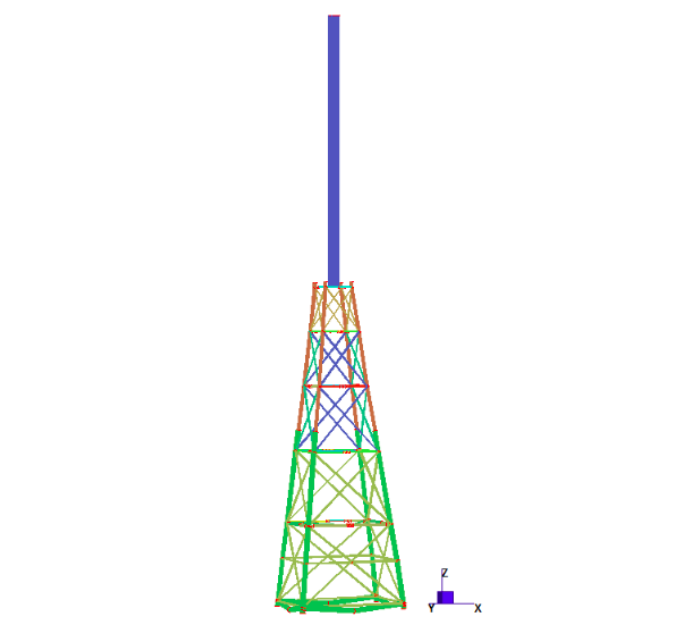
Figure 14. Crown pile model